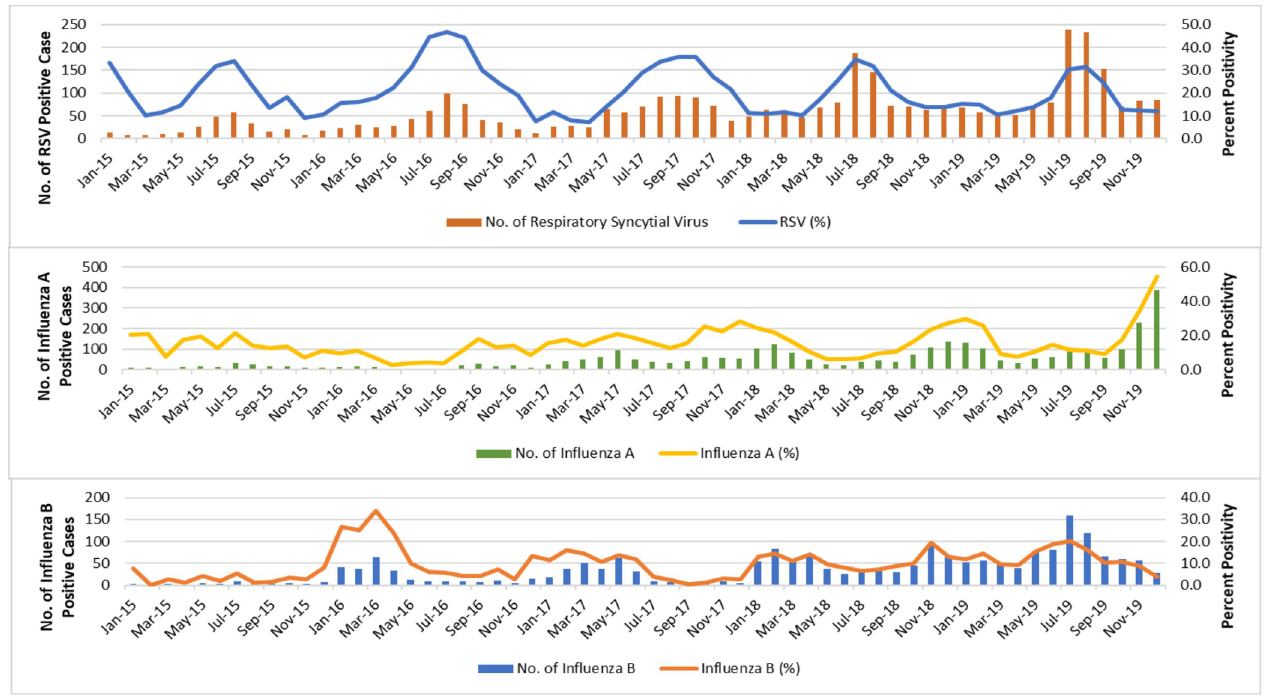
Fig 4. Monthly distribution of influenza A, influenza B and respiratory syncytial virus from January 2015 to December 2019.